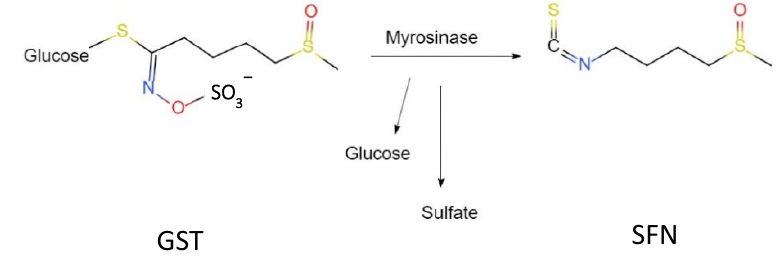
Figure 1. Chemical reaction of SFN and structure.